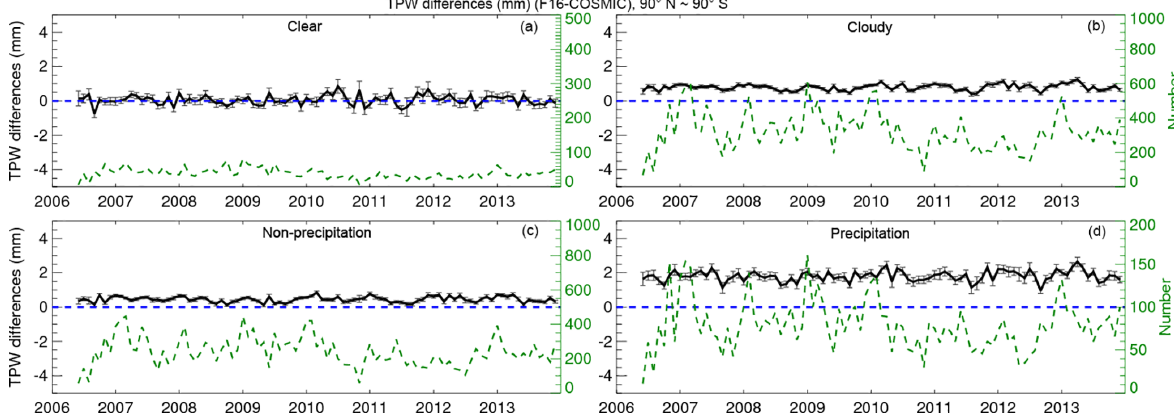
Figure 7. The time series of monthly mean F16 – COSMIC TPW differences under (a) clear, (b) cloudy, (c) cloudy but non-precipitating, and (d) precipitating conditions. The black line is the mean difference for microwave radiometer minus COSMIC; the vertical lines superimposed on the mean values are the standard error of the mean. The number of the monthly MW radiometer–COSMIC pairs is indicated by the green dashed line (scale on the right y